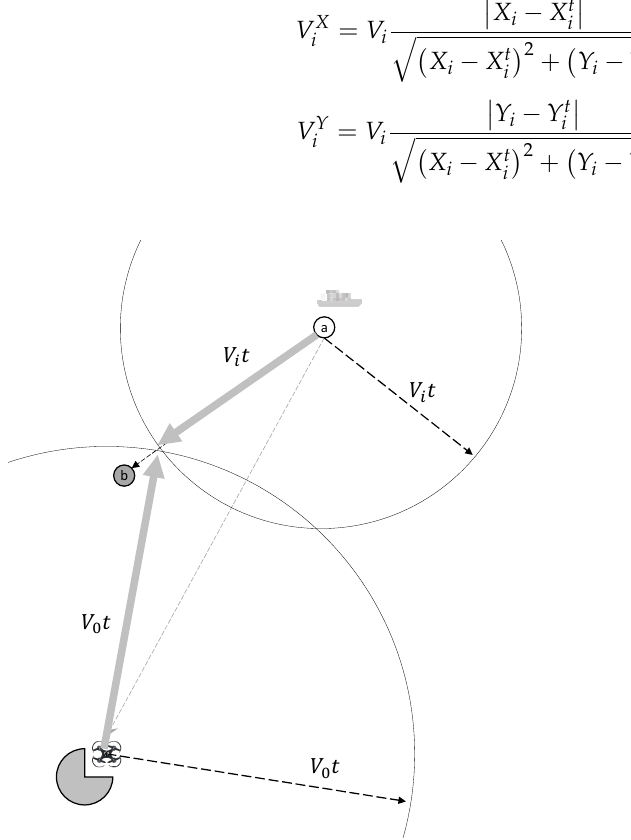
Figure 8. A conceptual diagram of the meeting model. Algorithm 1 Dichotomy algorithm (DA).